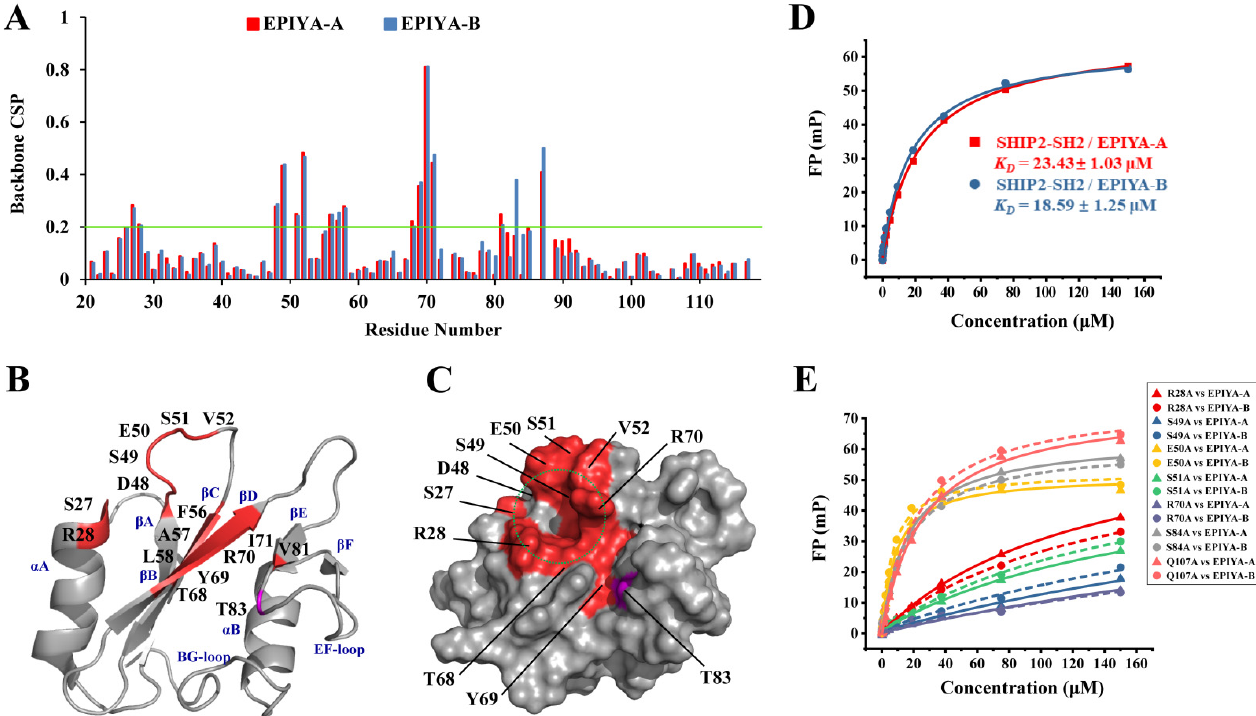
Figure 5. The binding interface and affinity of SHIP2-SH2 for CagA phosphopeptides from EPIYA-A and EPIYA-B motifs. ( A ) The chemical shift perturbation (CSP) of each residue during NMR titration with 8-mer CagA EPIYA-A and EPIYA-B phosphopeptides is shown with the threshold of 0.2 ppm for significant CSP marked by a green line. ( B , C ) The residues with CSPs larger than 0.2 ppm during the titration of 8-mer CagA EPIYA-A and EPIYA-B phosphopeptide are mapped onto ribbon representation ( B ) and molecular surface representation ( C ) of SHIP2-SH2 structure (PDB ID: 2MK2). Secondary elements are labeled in blue font ( B ), and the pY-pocket is indicated by a green dashed circle ( C ). ( D ) Binding affinities of 13-mer EPIYA-A and 13-mer EPIYA-B phosphopeptides for SHIP2-SH2 revealed by FP assay. The fitted dissociation constants ( K D , μ M) are indicated as inset, respectively. ( E ) Key residues of SHIP2-SH2 for binding to 13-mer EPIYA-A and 13-mer EPIYA-B phosphopeptides revealed by mutagenesis and FP assay. The determined K D values are shown in Table 1.